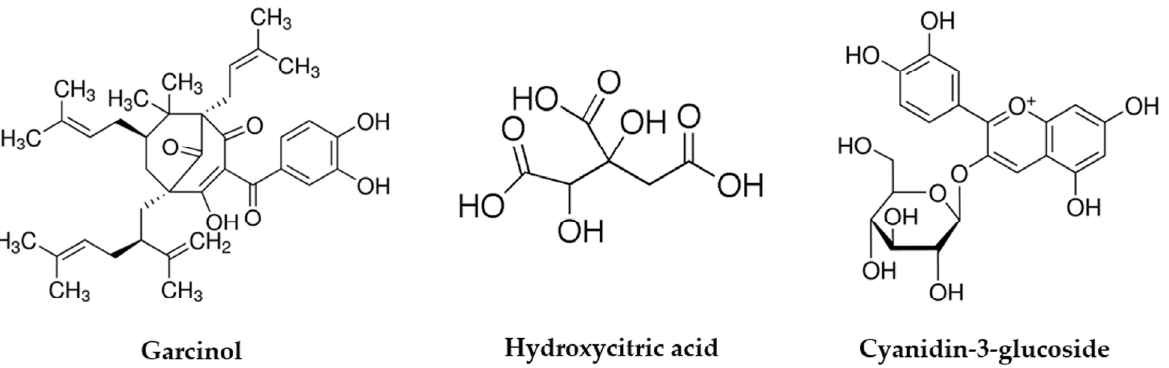
Figure 1. Chemical structure of bioactive ingredients isolated from G. indica